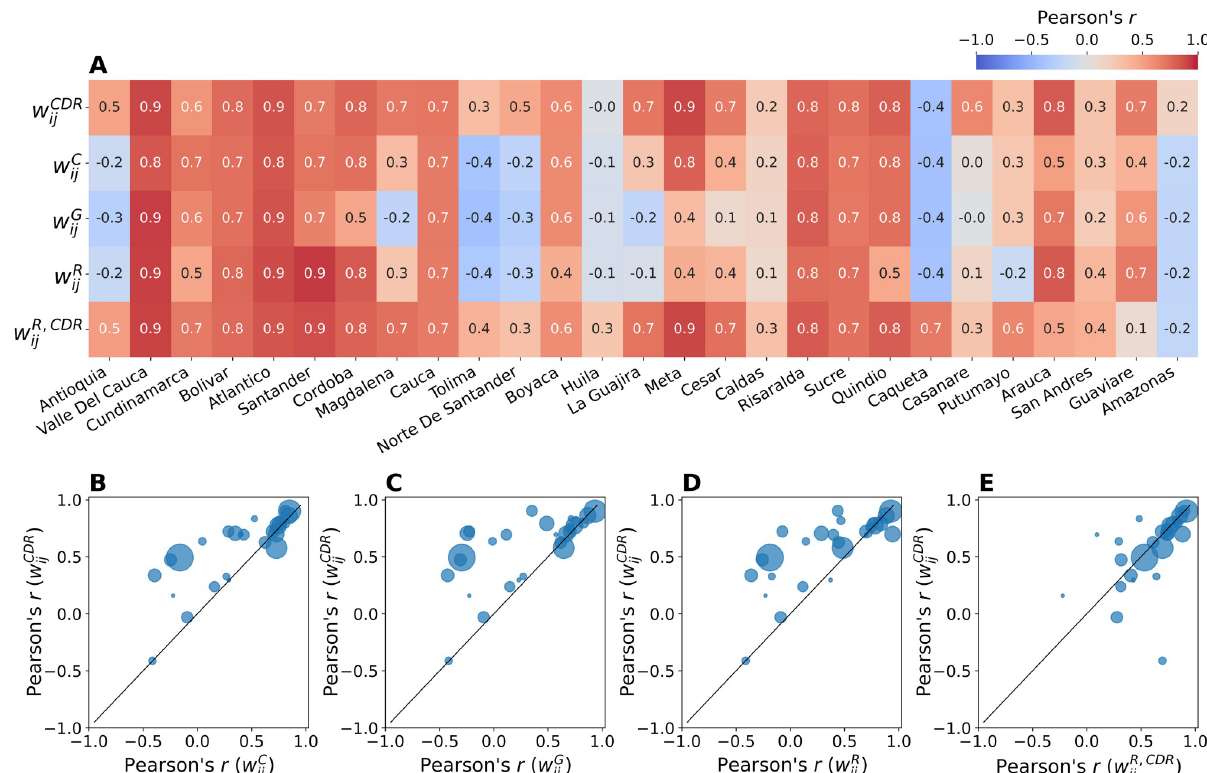
Fig 6. Correlation between model estimates and official surveillance data. ( A ) The heatmap shows the Pearson’s r correlation obtained by comparing the model estimates generated by each mobility network (on the y-axis) and the official surveillance times series by department (on the x- axis, sorted by population size). The bottom row shows the comparison between the Pearson’s r correlation obtained for the CDR-informed network (y-axis) with the Pearson’s r correlation obtained for the census network ( B ), the gravity network ( C ), the radiation network ( D ), and the hybrid radiation network ( E ). Point size corresponds to population